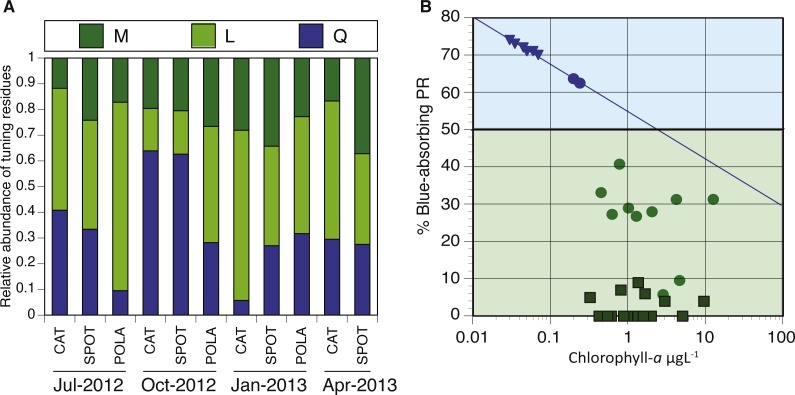
Spectral tuning of rhodopsins in our dynamic system and a comparison to previous studies.(A) Relative abundance of blue/green variants of proteorhodopsin (PR) in metagenomes (294–2,112 reads per sample): leucine (L) is represented by light green, methionine (M) by dark green and glutamine (Q) by blue. There was not enough data to plot tuning distribution at POLA in April 2013. (B) 0.25 µgL −1 is the Chl-a threshold between environments dominated by blue-tuned PR or green-tuned based on data from this paper and previous publications. Triangles, squares and circles denote data from Dubinsky et al. (2017), Brindefalk et al. (2016) and this study, respectively. The trendline for samples with Chl-a concentration below 0.25 µgL−1 follows the equation %Blue- PR = [ − 0.055∗ln(Chl − a) + 0.55]∗100, R2 = 0.99.